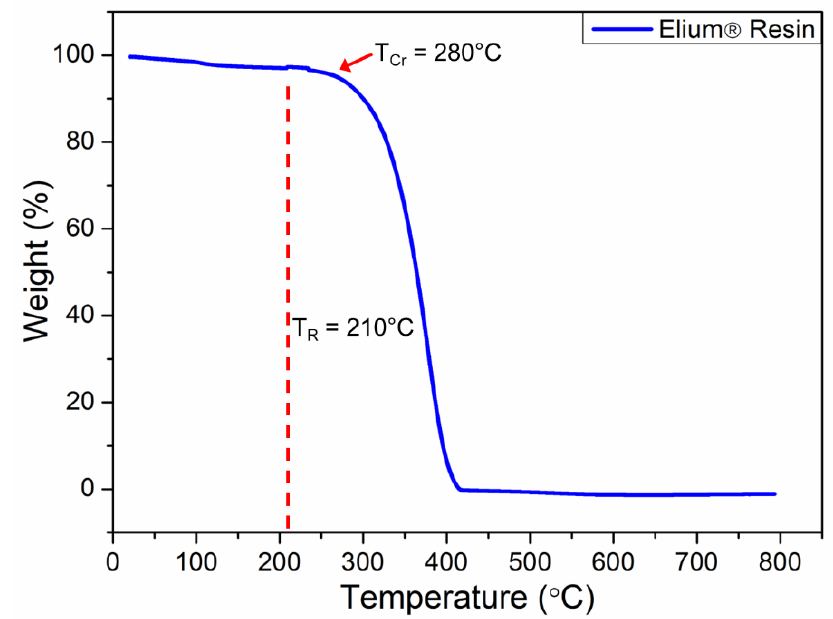
Figure 6. Thermal degradation of the liquid thermoplastic resin.